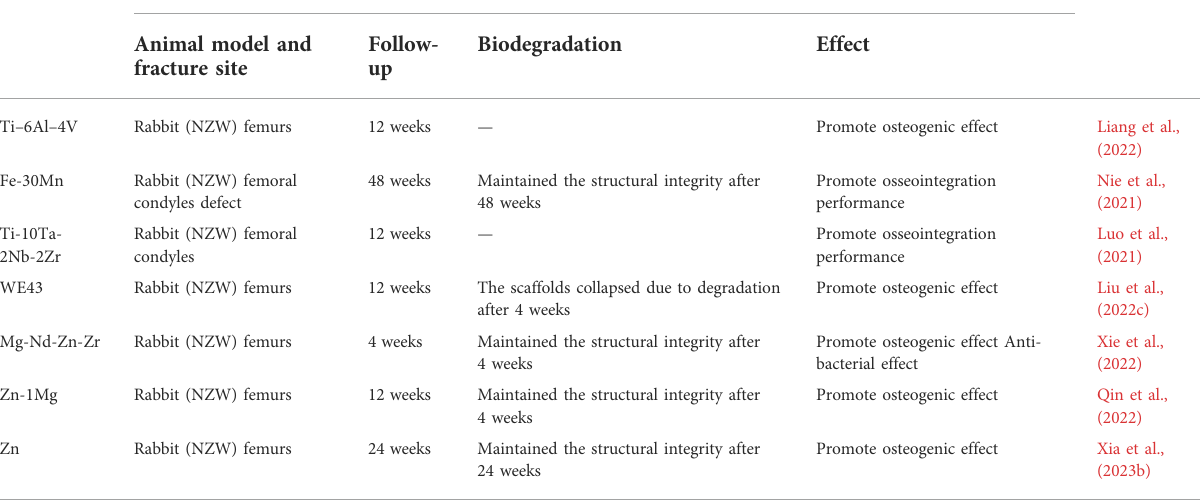
TABLE 5 Summary of the application of AM using L-PBF for orthopedic applications.Summary of the application of AM using L-PBF for orthopedic applications.